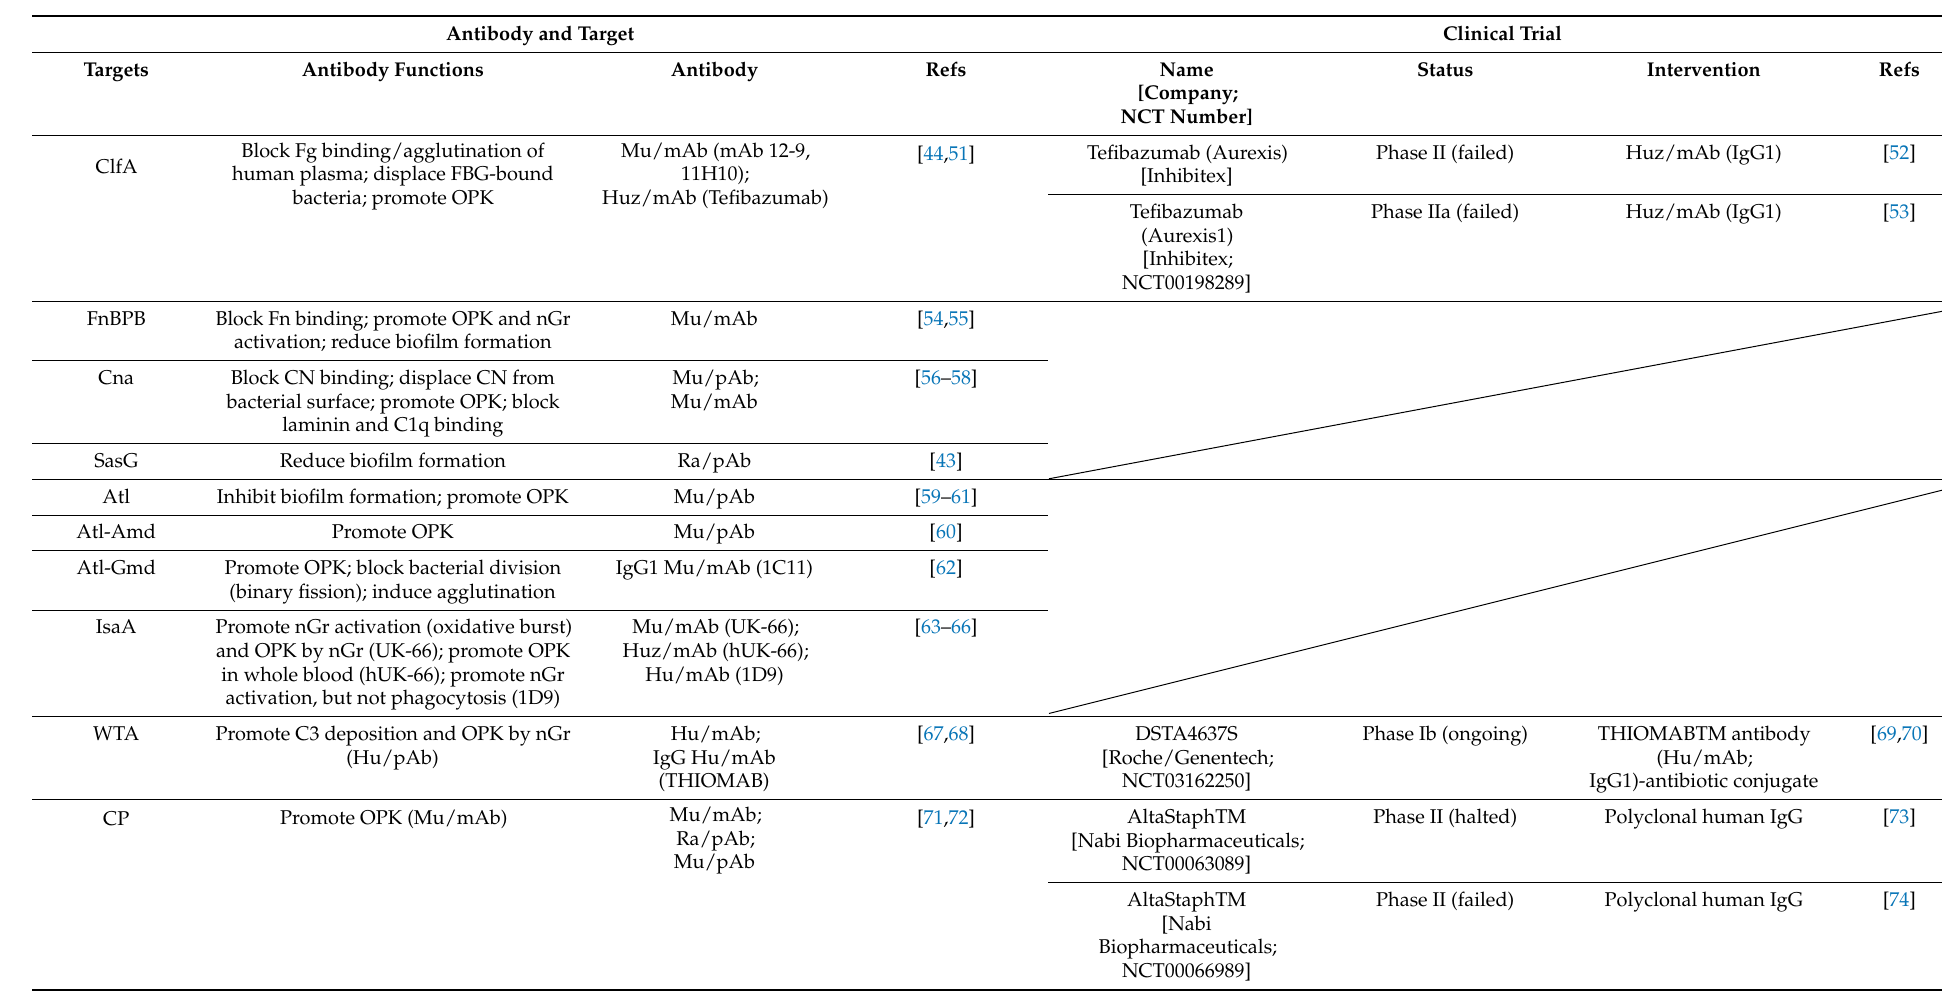
Table 1. Studies and clinical trials on potential anti-biofilm targets and antibodies. Adapted with permission from Raafat et al. [42]. 2019, Elsevier. Antibody and